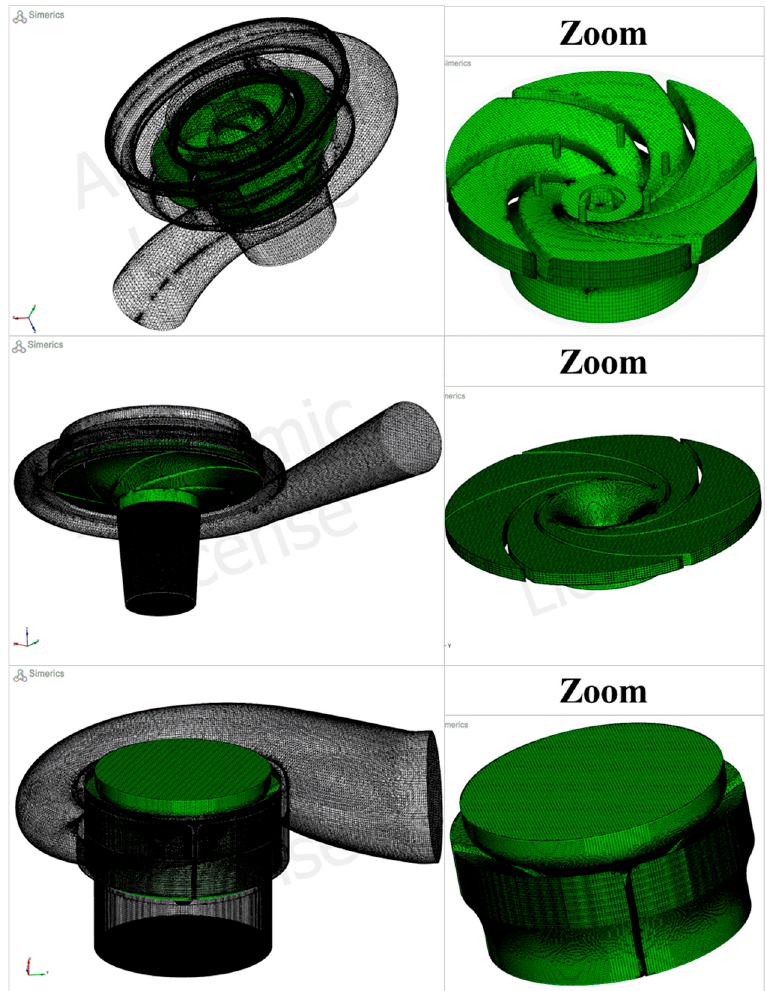
Figure 2. Binary tree mesh for three pumps.